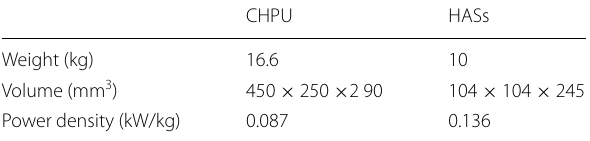
Table 2 Comparison of hydraulic actuating